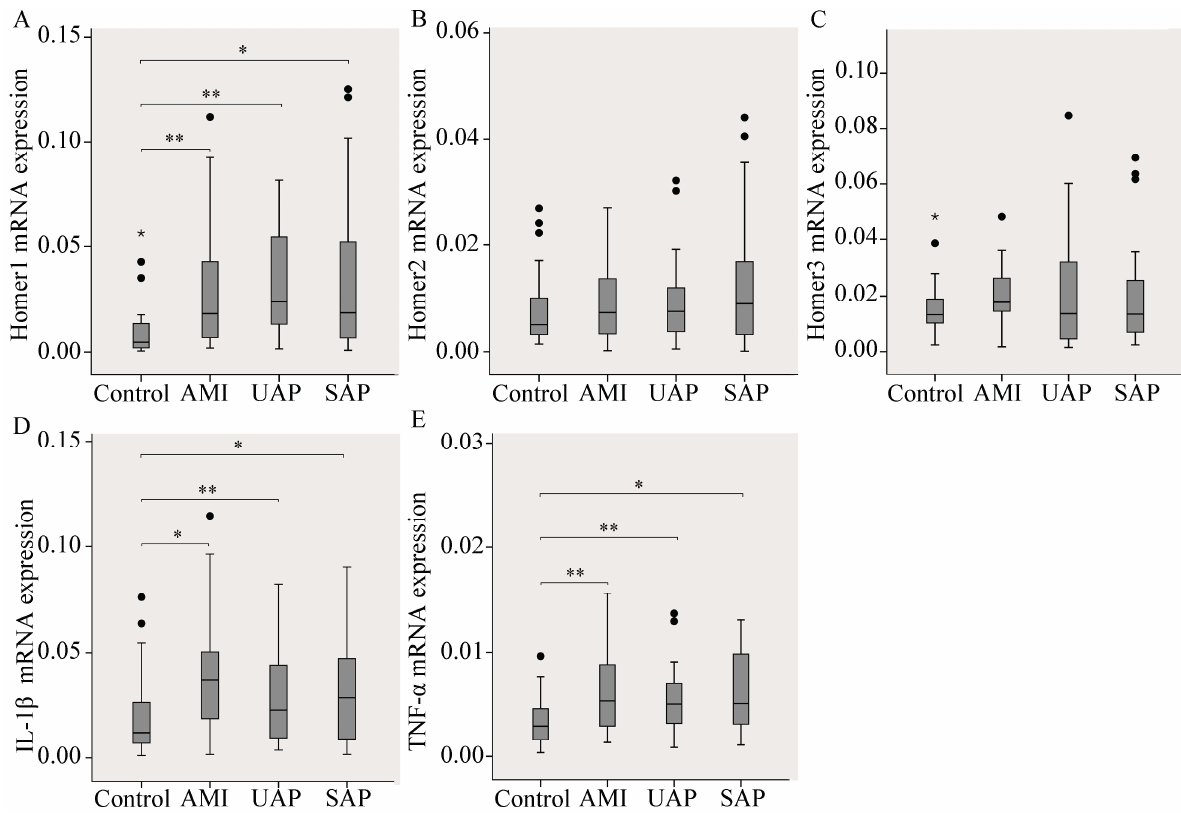
Figure 1. The expression of Homer1 ( A ); Homer2 ( B ); Homer3 ( C ) and the pro-inflammatory cytokine interleukin-1 β (IL-1 β ) ( D ); and tumor necrosis factor- α (TNF- α ) ( E ) in peripheral blood leukocytes from CAD patients. Results are shown as median box and whisker plots. Statistical differences in relative expression between CAD patients and controls are indicated as asterisks: * ( p value, Mann-Whitney test). * p < 0.05, ** p < 0.01 vs. Control. “•” represents outliers; “ * ” represents extreme